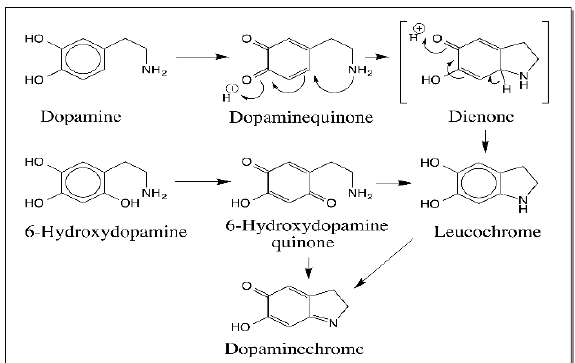
Figure 4. Reactions of quinone with internal amines. Dopamine quinone formed by the two-electron oxidation of dopamine reacts rapidly with the internal amino group forming leucochrome, which is converted readily to dopaminechrome similar to the dopachrome conversion reaction shown in Figure 1. Interestingly dopaminechrome is also generated during the oxidation of 6-hydroxydopamine as a condensation of product of 6-hydroxydopaminequinone.